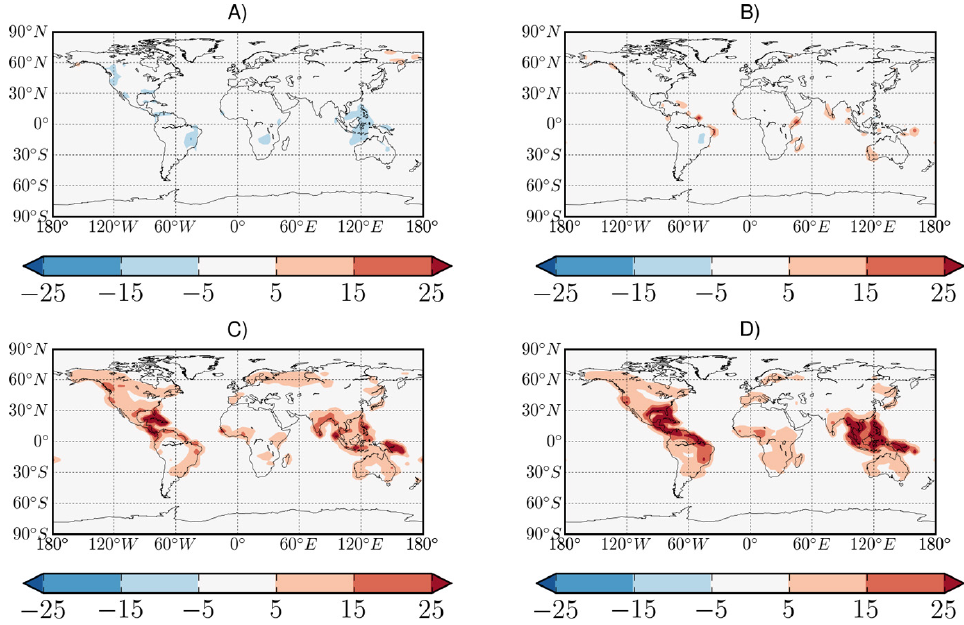
Fig. 11. Increases in aerosol number concentrations due to ultrafine aerosol growth by fully kinetic condensation approach as compared with the semi-empirical scheme for June 2001. Changes in global aerosol number concentrations (average over 1km) if all of the total OA mass is distributed as effectively non-volatile, as compared with the case where 50% of it partitions to the pre-existing aerosol mass. The colorscale indicates percentage changes in number concentrations of particles > 3nm (A) , > 10nm (B) , > 40nm (C) , and > 80nm (D)